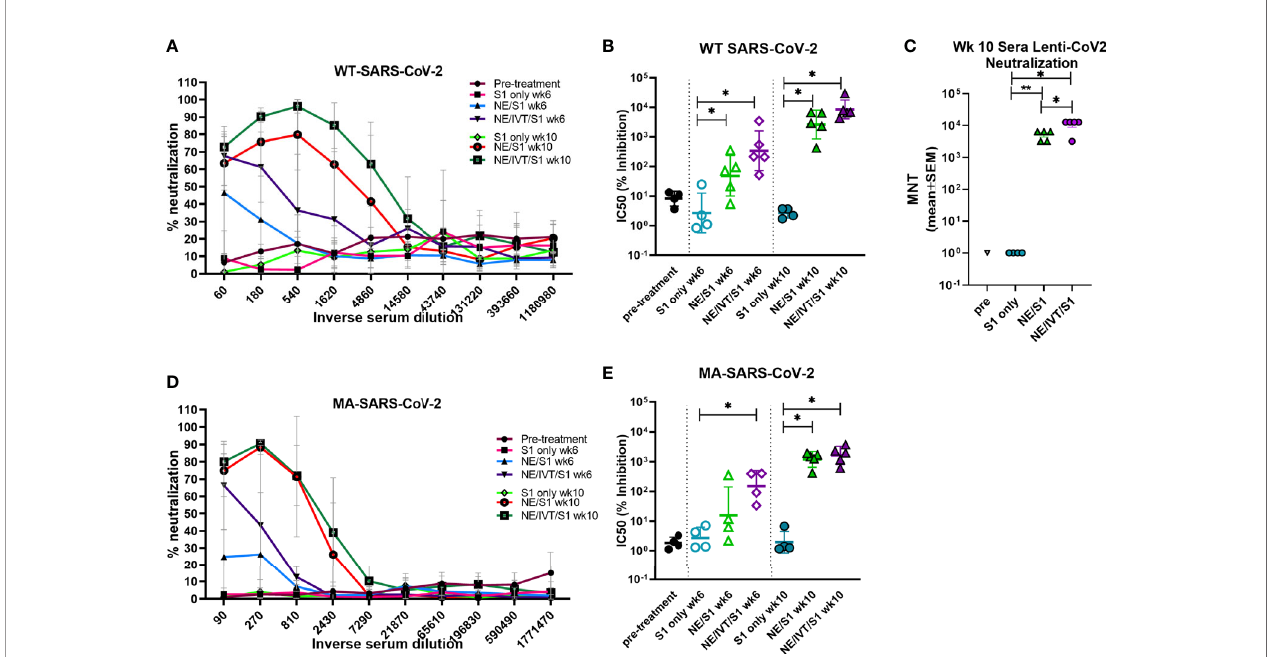
FIGURE 4 | Virus neutralization titers to homologous and heterologous SARS-CoV-2 following immunization. Neutralizing antibody titers in serum from mice receiving two (wk 6) or three (wk 10) immunizations were determined using microneutralization assays against the WT SARS-CoV-2 (2019-nCoV/USA-WA1/2020), pseudotyped lentivirus expressing the WT SARS-CoV-2 spike protein (Lenti-CoV2), and MA-SARS-CoV-2. Viral neutralization was plotted as percentage inhibition of viral infection in Vero E6 cells (for WT virus and MA-virus) relative to virus only (no serum) positive controls versus the inverse serum dilution. The titer at which 50% inhibition of infection was achieved (IC50) was determined for the (A, B) WT virus and the (D, E) MA virus. (C) The results were con fi rmed for the same week 10 serum samples using the Lenti-CoV2 pseudovirus expressing fi re fl y luciferase with HEK-293T cells expressing hACE2. Microneutralization titers using the Lenti-CoV2 were determined by detecting viral infection by measuring luminescence (*p < 0.05, **p < 0.01 by Mann-Whitney U test). Pretreatment (pre) sera were obtained from the same set of mice before